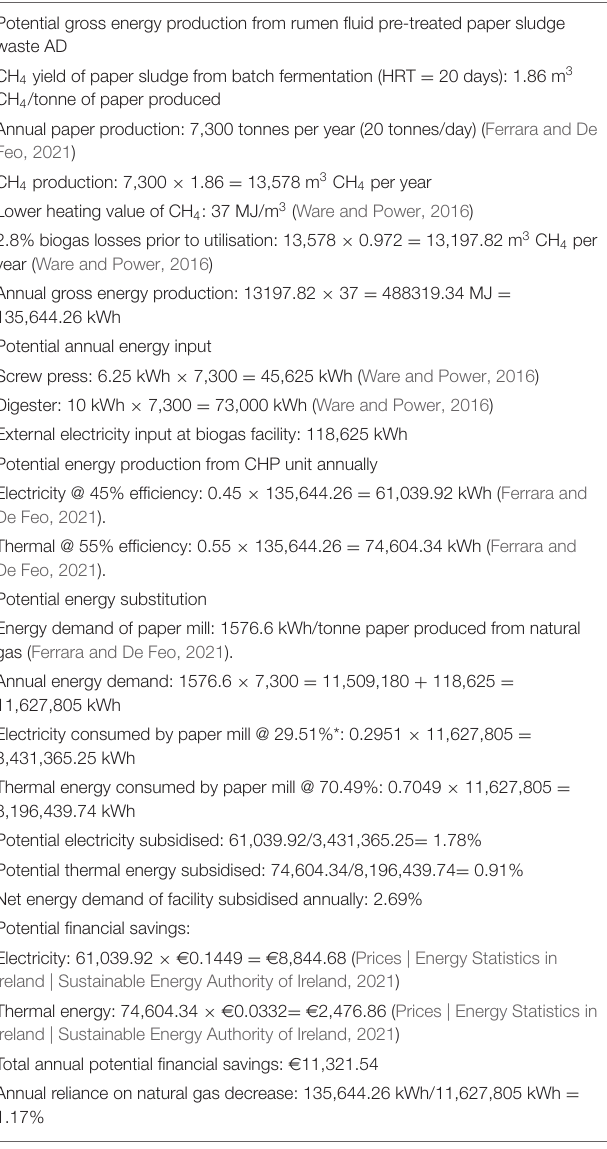
TABLE 3 | Energy analysis of biomethane produced annually from rumen fluid pre-treated paper sludge waste available from an Italian paper mill combusted using a CHP